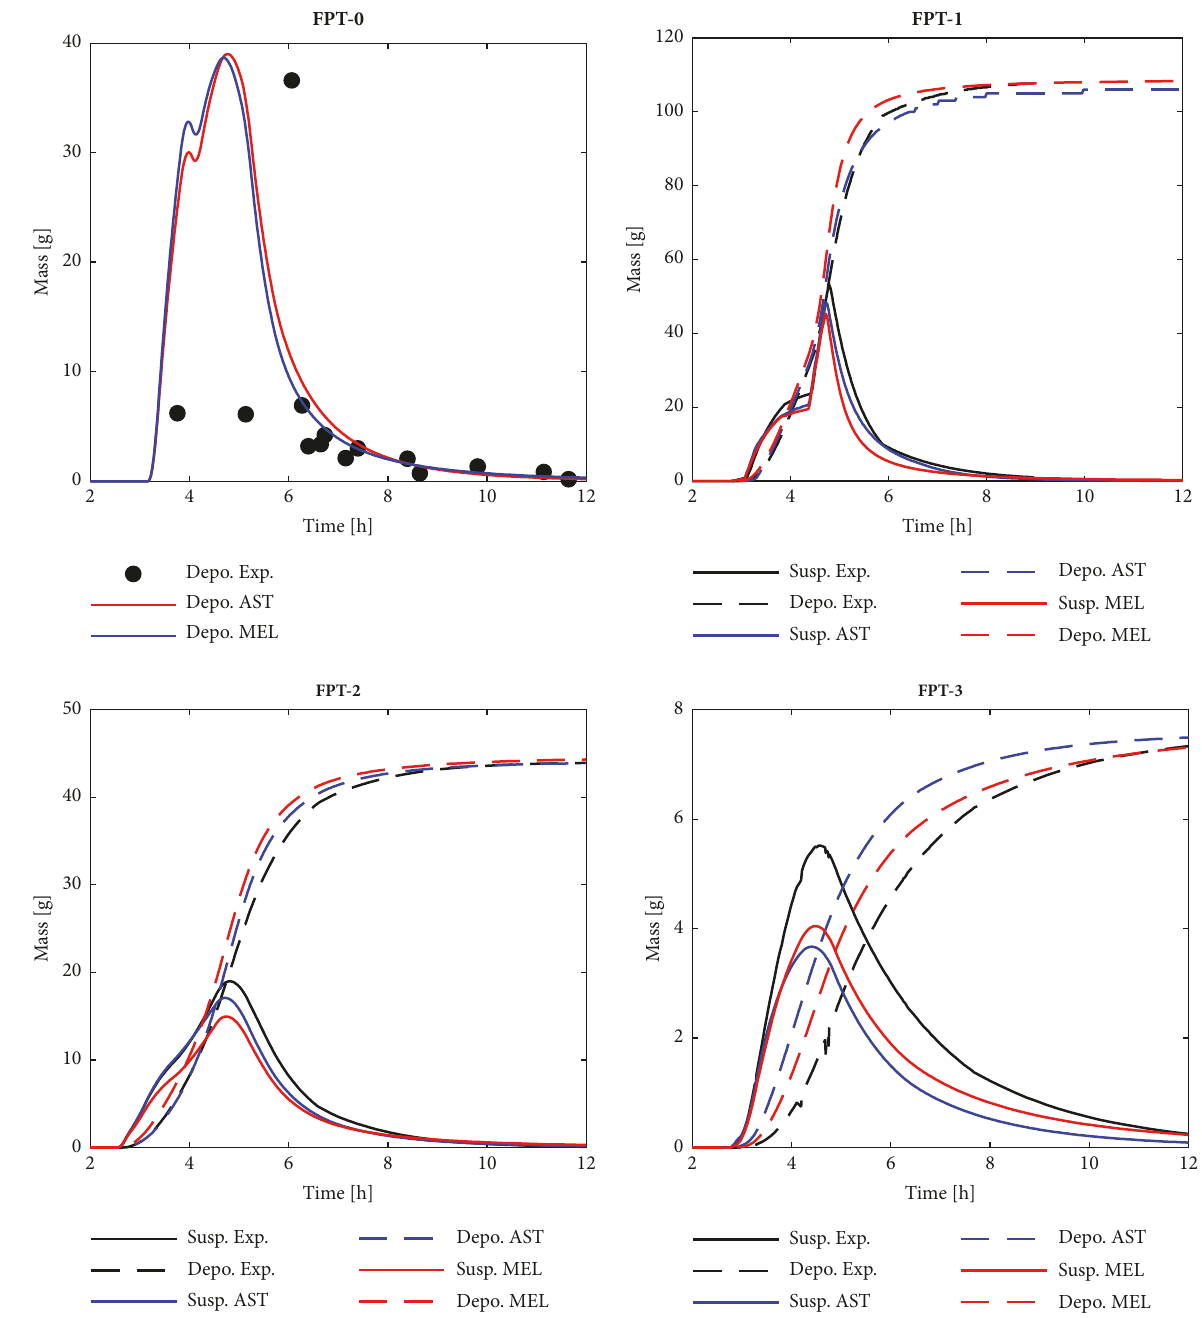
Figure 11: Suspended and deposited aerosol mass during the Ph´ebus FPT